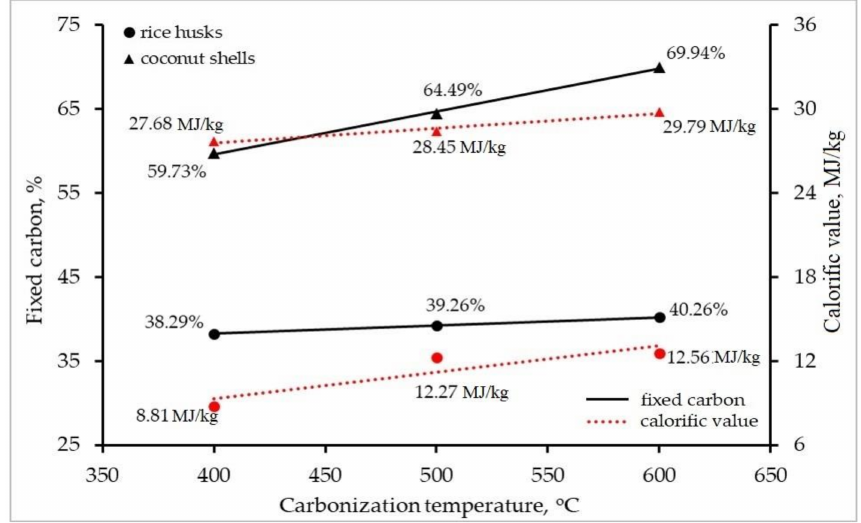
Figure 3. Effect of heating temperature on fixed carbon and calorific value of